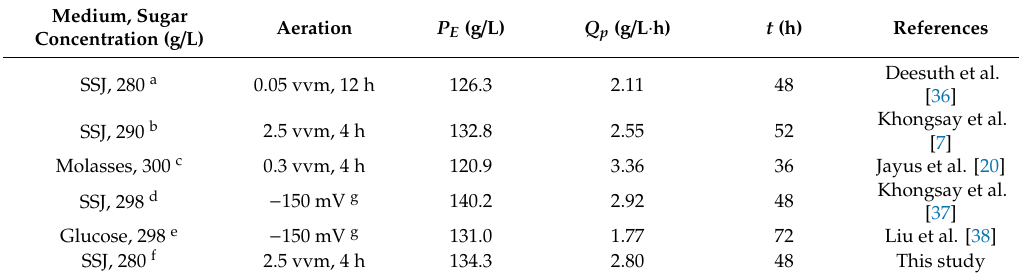
Table 6. Comparison of very high gravity (VHG) ethanol fermentation under aeration in various studies. Medium, Sugar Aeration P E (g / L) Q p (g / L · h) t Concentration (g / L)